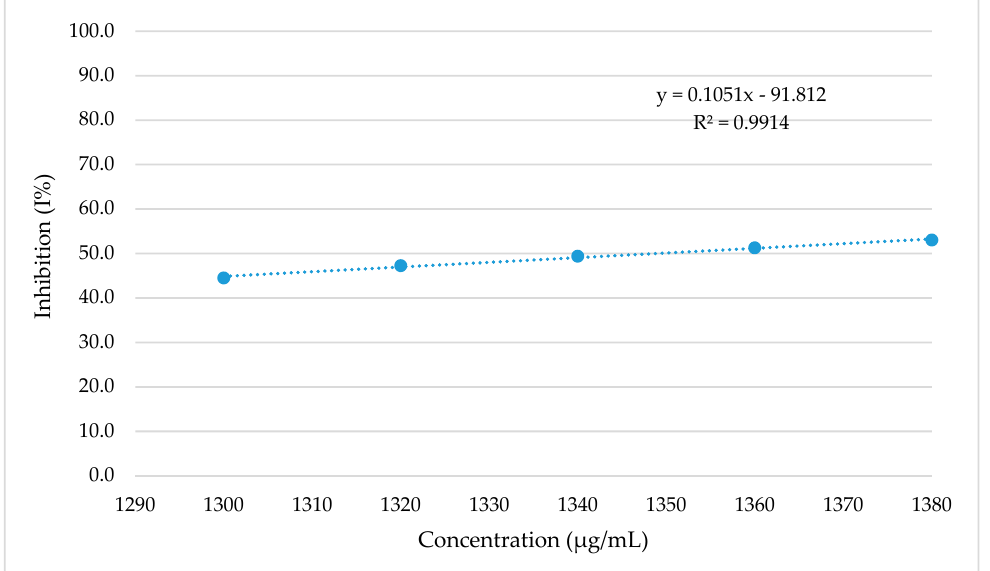
Figure 12. The antioxidant ability of dried extract obtained at optimum conditions.